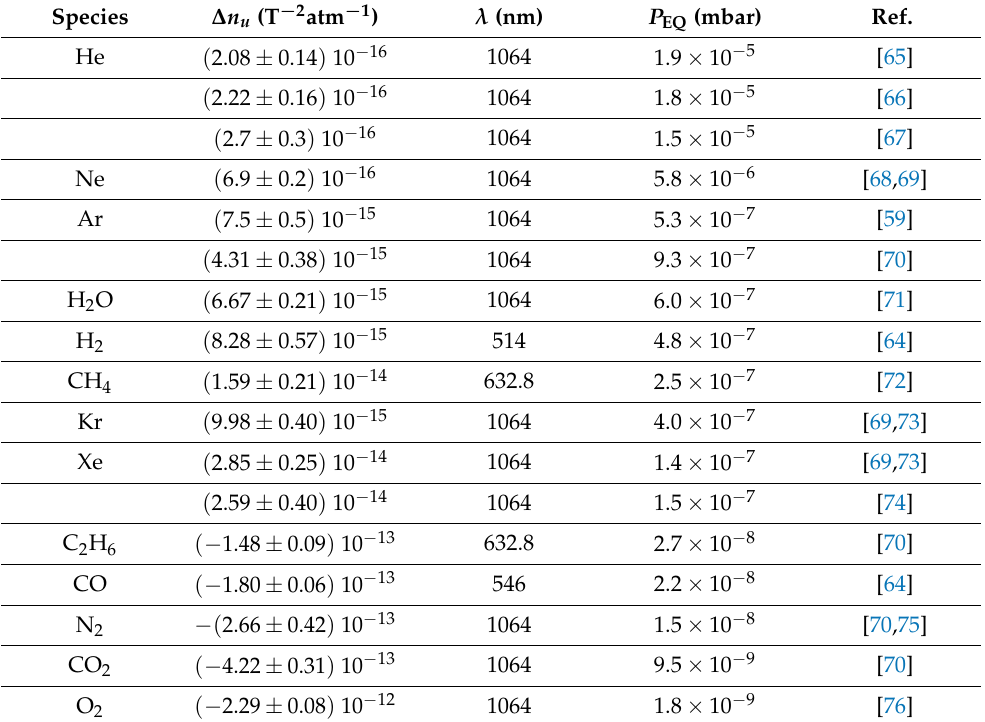
Table 1. Unitary magnetic birefringence of common inorganic gaseous species. The equivalent partial pressure which would mimic a VMB signal are also